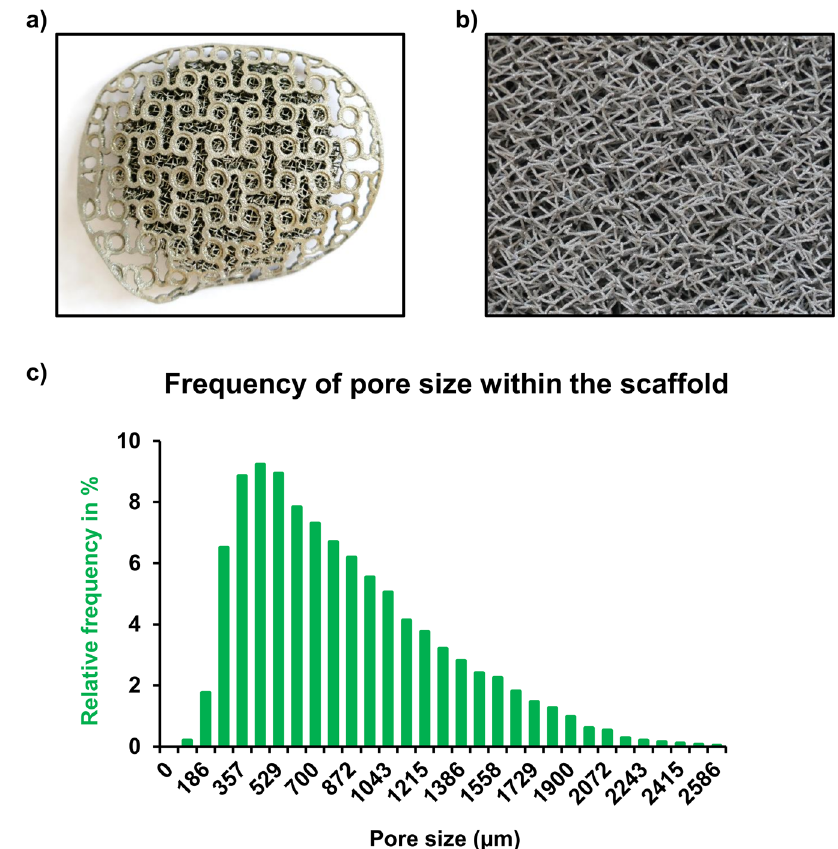
Fig. 2 a , b Examplary images of the scaffold [( a ): from top {overview}; ( b ): from bottom {high magni fi cation}]. c Relative frequency of occurrence of pores sorted by size within the